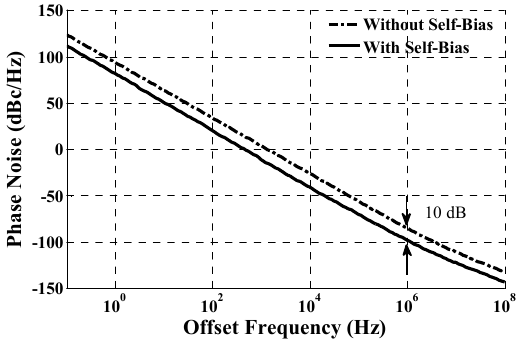
Figure 6. The simulated phase noise of both circuits.